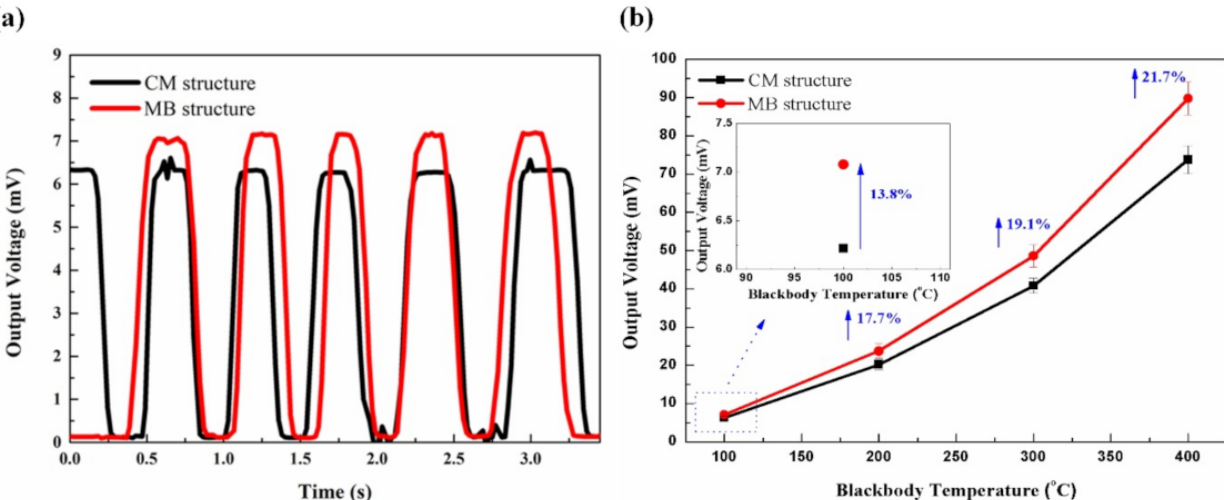
Figure 6. ( a ) Measured response for both types of the thermopiles, ( b ) voltage–temperature response curves of the two thermopiles in a temperature range from 100 to 400 ◦ C. The inset shows the amplified output voltage at 100 ◦